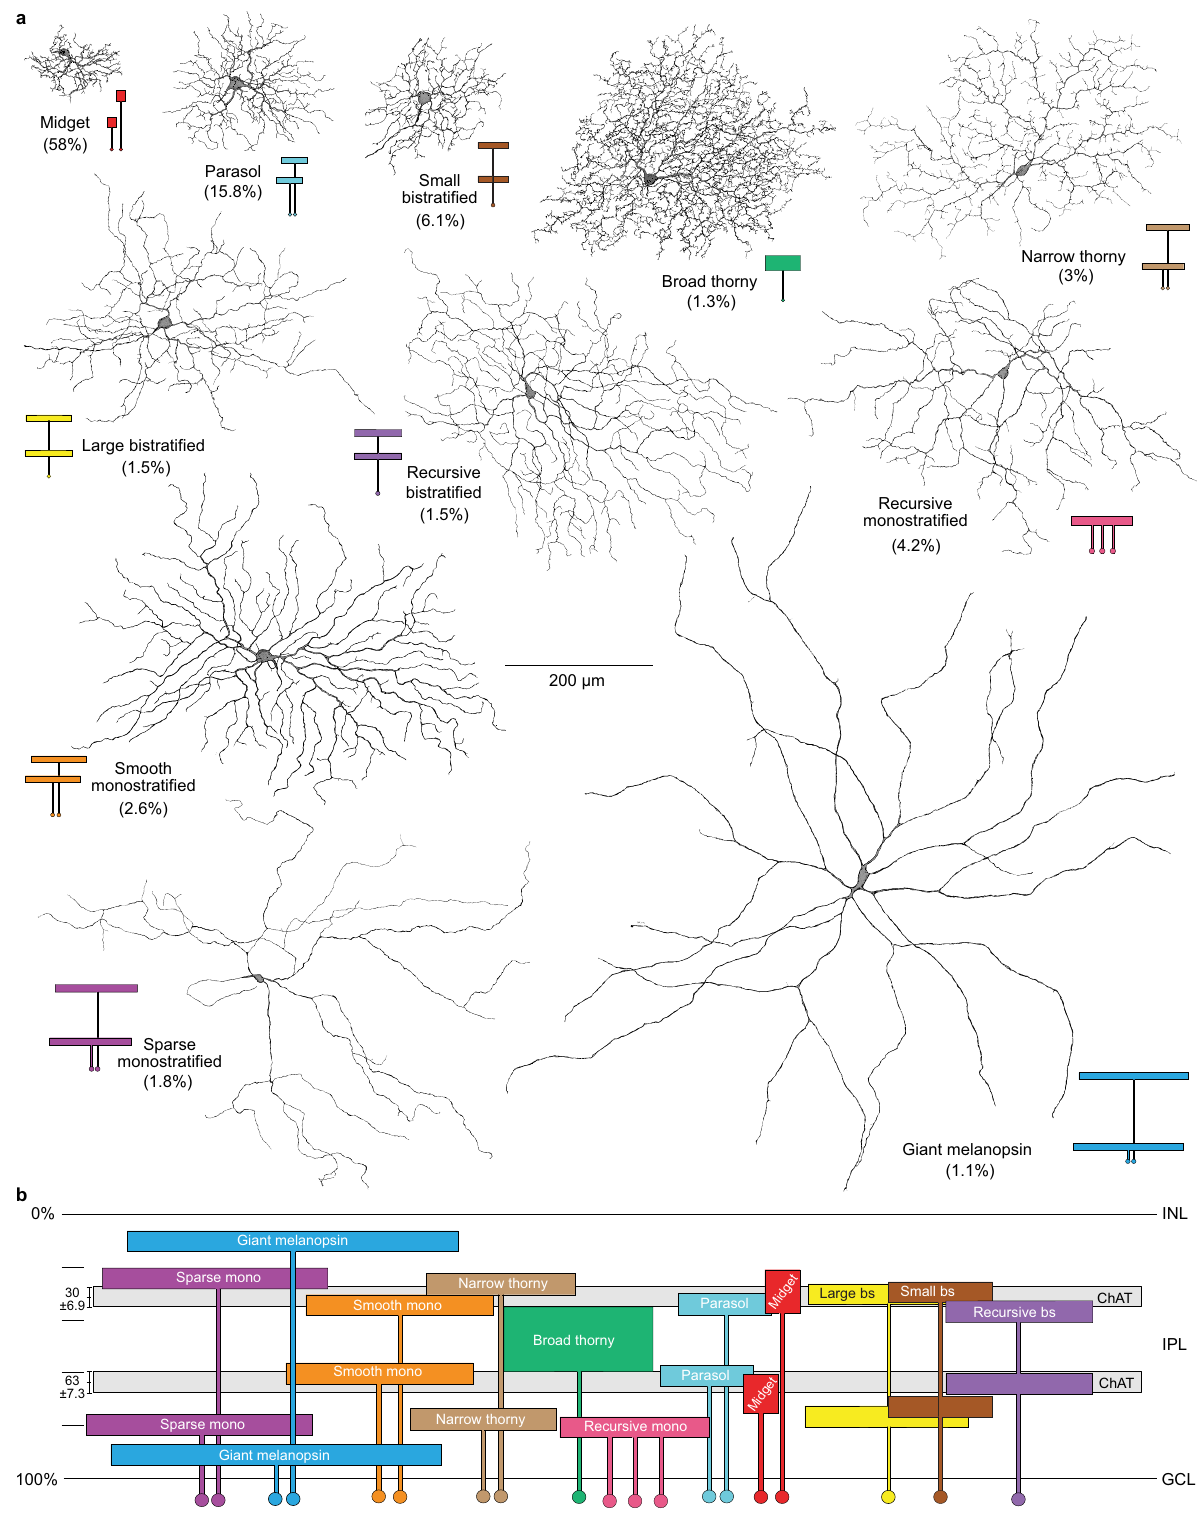
recursive bistrati fi ed cells transiently depolarized and spiked at both light ONset and OFFset (Fig. 3b) as expected from their depth of strati fi cation in the ON and OFF subdivisions of the inner plexiform layer (IPL). Direction selectivity was found in response to moving bar stimuli (Fig. 3c, d) ( n = 26 cells; mean ± s.d., DSI = 0.82 ± 0.20). The relatively low density of the